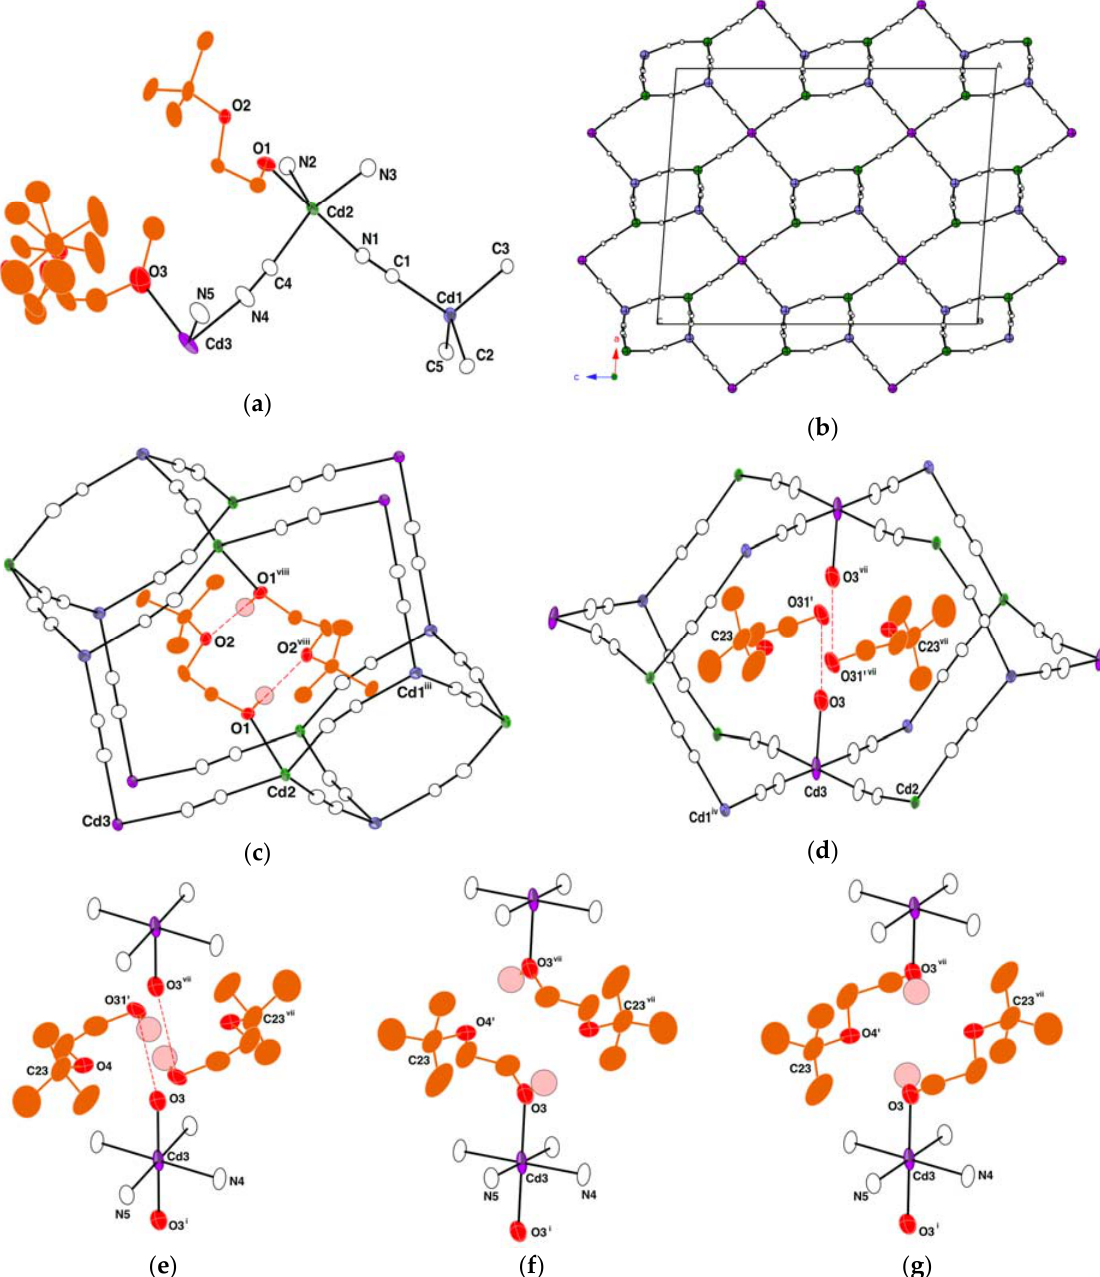
Figure 2. The crystal structure of II . Because arrangements of cyanides (Cd ‐ NC ‐ Cd or Cd ‐ CN ‐ Cd) are disordered, the cyanide atoms are labeled arbitrarily: ( a ) Asymmetric unit containing disordered parts. Displacement ellipsoids are drawn at the 50% probability level. H atoms are omitted for clarity; ( b ) The Cd(CN) 2 network view along the b axis; ( c ) Hydrogen bonds between neighboring tBucel ligands on Cd2 in the cavities of cadmium cyanide network of II . Displacement ellipsoids are drawn at the 50% probability level. H atoms, except for OH hydrogens, are omitted for clarity; ( d ) Cd(CN) 2 cavity around O3. Displacement ellipsoids are drawn at the 50% probability level. H atoms are omitted for clarity; ( e – g ). The disordered parts of the axial positions on the Cd3 and hydrogen bonds between the neighboring ligands. ( e ) Shows where water molecules coordinate to the Cd3. ( f , g ) show how the tBucel ligands coordinate to the Cd3. All hydrogen bonds might not be found due to the complexity of the observed disorder. (Symmetry codes: i = − x + 1/2, − y + 3/2, − z + 3/2; iii = − x , − y + 2, − z + 2; iv = x + 1/2, − y + 2, z ; vii = − x + 1/2, − y + 1/2, − z + 3/2; viii = − x + 1/2, y , − z + 2).